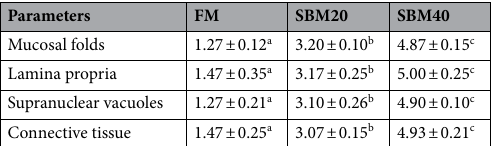
Comparison of composition and abundance of microflora. At the phylum level, the top 10 species of relative abundance were Proteobacteria , Firmicutes , Bacteroidetes , Actinobacteria and Cyanobacteria , etc . (Fig. 5). With the increase of SBM substitute level, the abundance of Proteobacteria significantly decreased in the SBM40 group (T-test, P < 0.05), and the abundance of Firmicutes and Bacteroidetes significantly increased in the SBM40 group (T-test, P < 0.05) (Fig. 6A and Supplementary Table 2). At the genus level, the top 10 species of relative abundance were Photobacterium , Faecalibacterium , Steno‑ trophomonas , Vibrio and Neisseria , etc . (Supplementary Fig. 2). The abundance of Photobacterium significantly decreased in the SBM40 group (T-test, P < 0.05), while the abundance of Bacteroides , Fusicatenibacter , Rothia , Intestinibacter , unidentified_Prevotellaceae , Halioglobus , Actinomyces , Anoxybacillus and Novosphingobium sig- nificantly increased in the SBM40 group (T-test, P < 0.05) (Fig. 6B and Supplementary Table 3).